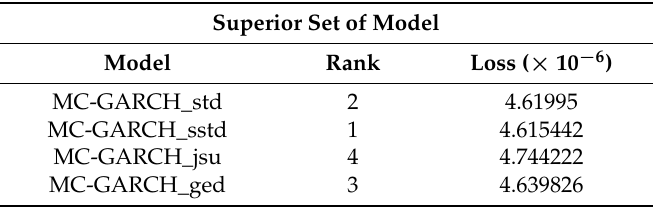
Table 7. Intraday VaR forecast: MCS results and